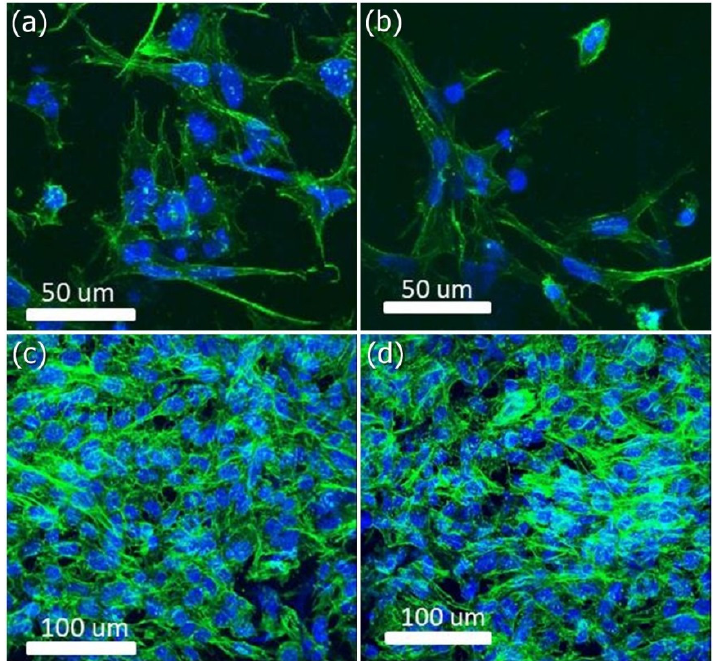
Figure 4. Cellular morphology of MG63 osteoblast-like cells on matrix. Representative images of MG63 osteoblast-like cells cultured on SrHANF and HANF. ( a , c ) SrHANF and ( b , d ) HANF; ( a , b ) after one day of culture. ( c , d ) after four days of culture. Cytoskeletal F-actin was stained green with FITC, and cell nuclei were stained blue with DAPI.